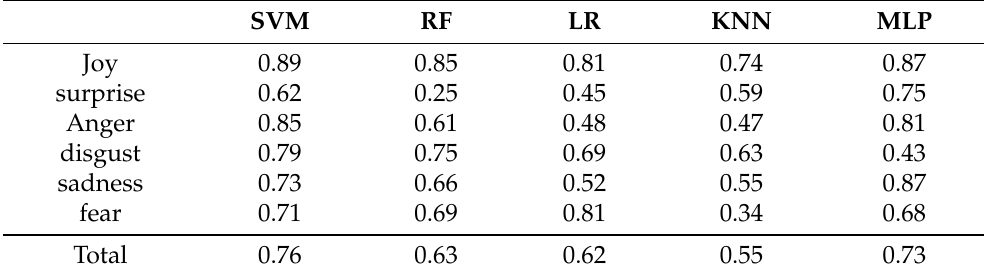
Table 1. Comparison of different classifiers’ results on the eNTERFACE05